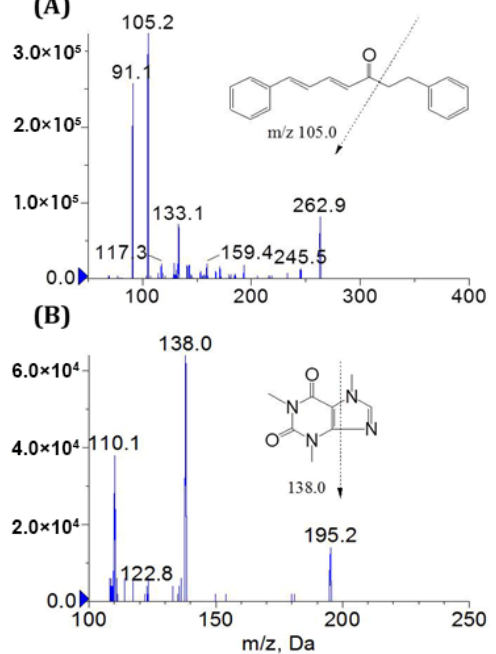
Figure 1. Full-scan product ion spectra of [M + H] + for alnustone ( A ) and caffeine (IS, B ).